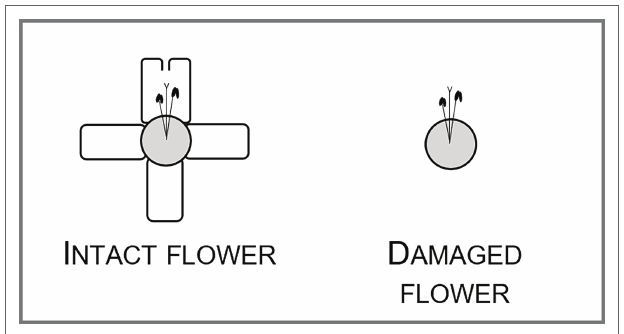
FIGURE 4 | Schematic representation of the most pronounced damage caused by a lycaenid caterpillar florivore. The floral tube, the five corolla lobes, stamens and style are